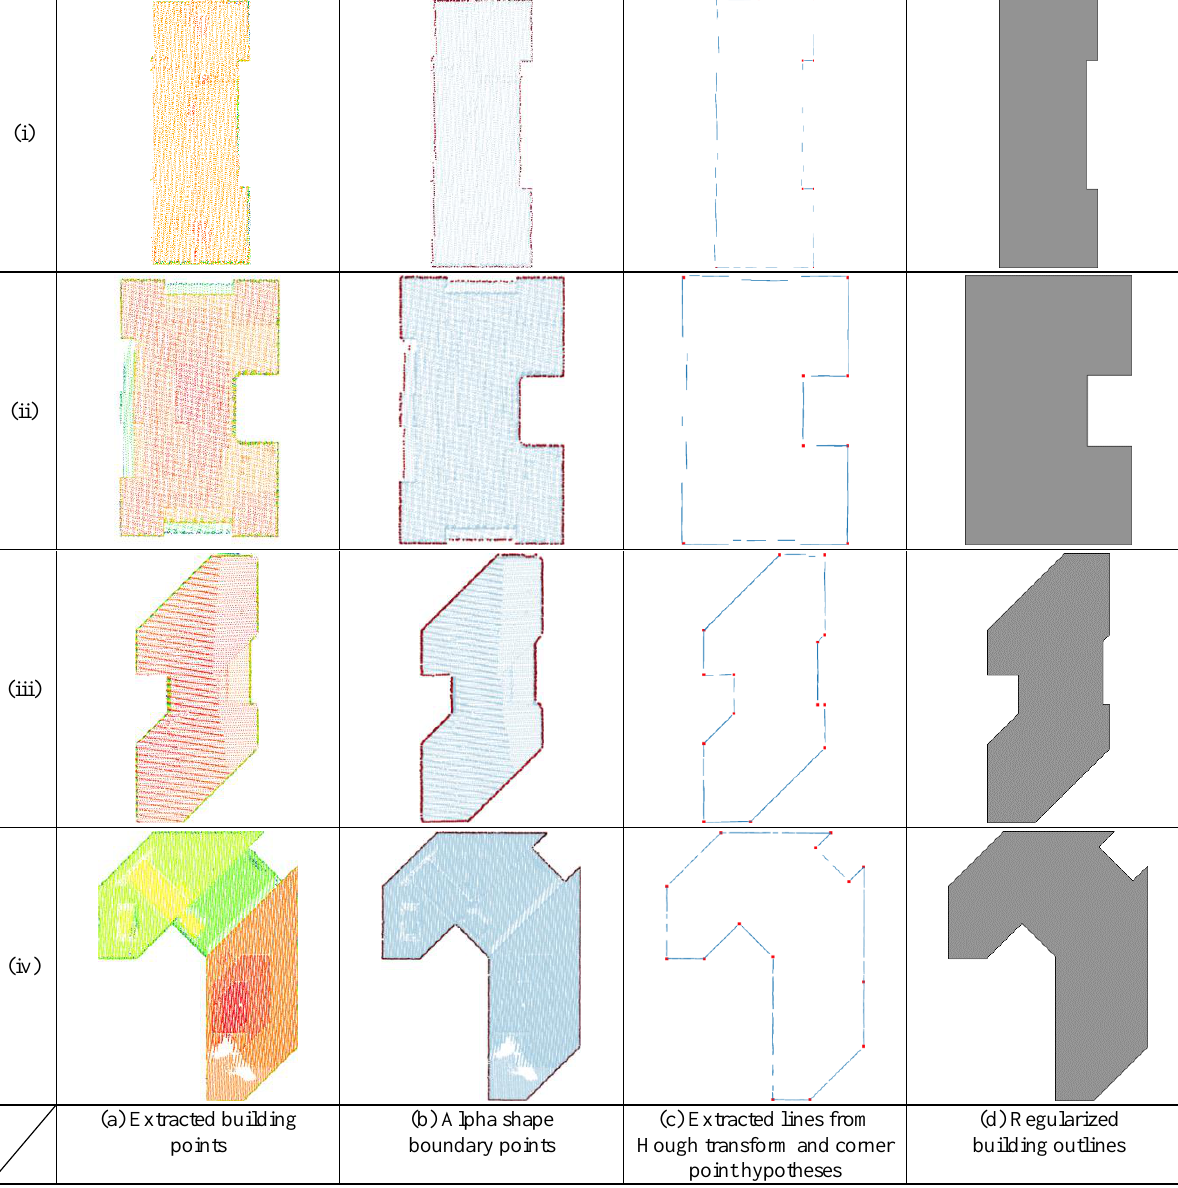
Figure 8. Results with intermediate steps for buildings from the Toronto data